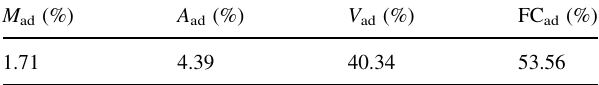
Table 1 Proximate analysis of coal